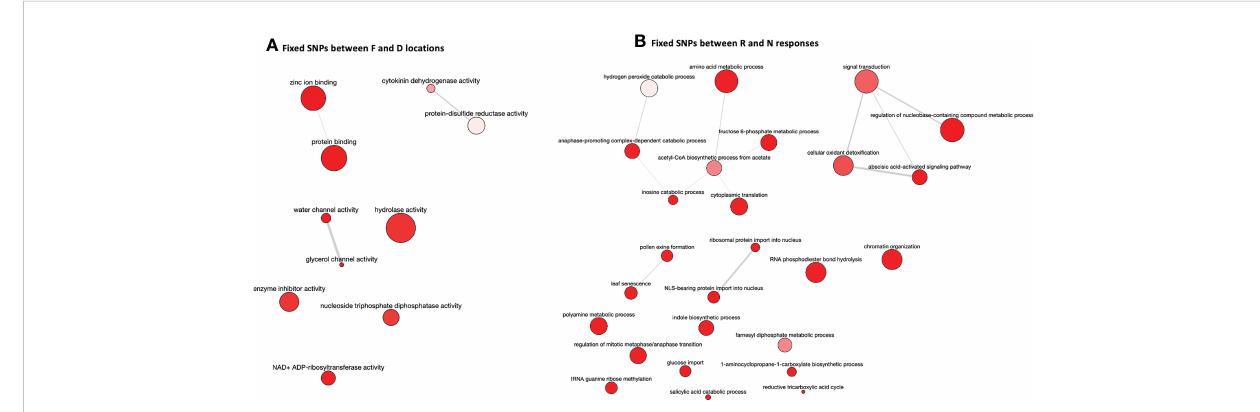
FIGURE 10 GO term enrichment results for genes containing fi xed SNPs between F and D locations (A) and R and N responses (B) visualized using